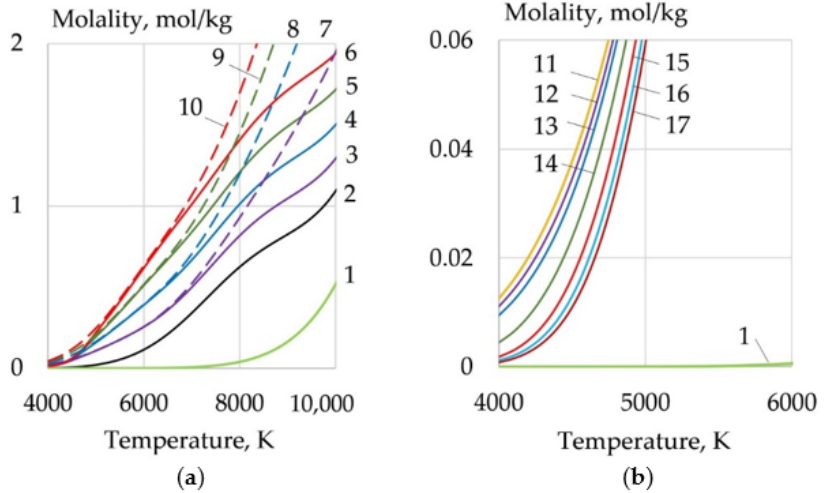
Figure 9. Change in the concentration of electrons in the equilibrium system, wt.% at 0.1 MPa: 95Ar + 5Fe ( a ) and 95Ar + 5Al ( b ) at 0.1 MPa: (1) 100Ar; (2) 95Ar + 5Fe; (3) 90Ar + 5Fe + 5LaF 3 ; (4) 85Ar + 5Fe + 10LaF 3 ; (5) 80Ar + 5Fe + 15LaF 3 ; (6) 75Ar + 5Fe + 20LaF 3 ; (7) 90Ar + 5Fe + 5LaB 6 ; (8) 85Ar + 5Fe